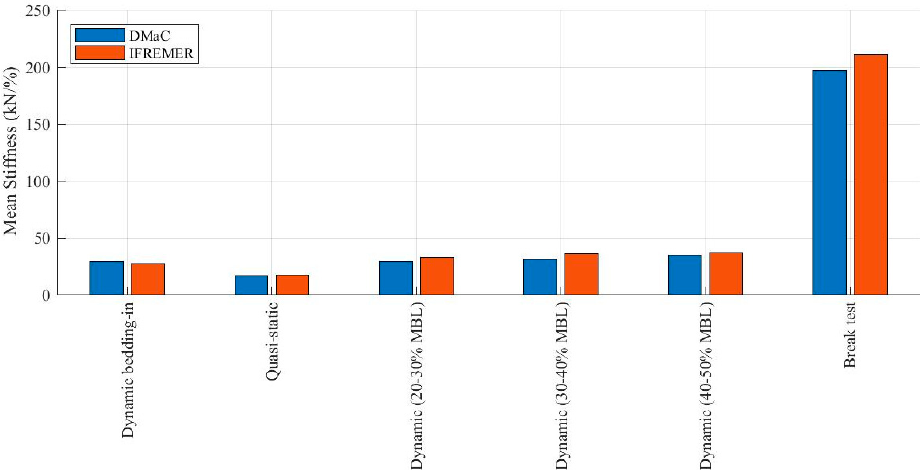
Figure 12. Comparison of the mean stiffness properties of the hybrid rope determined at DMaC and IFREMER.